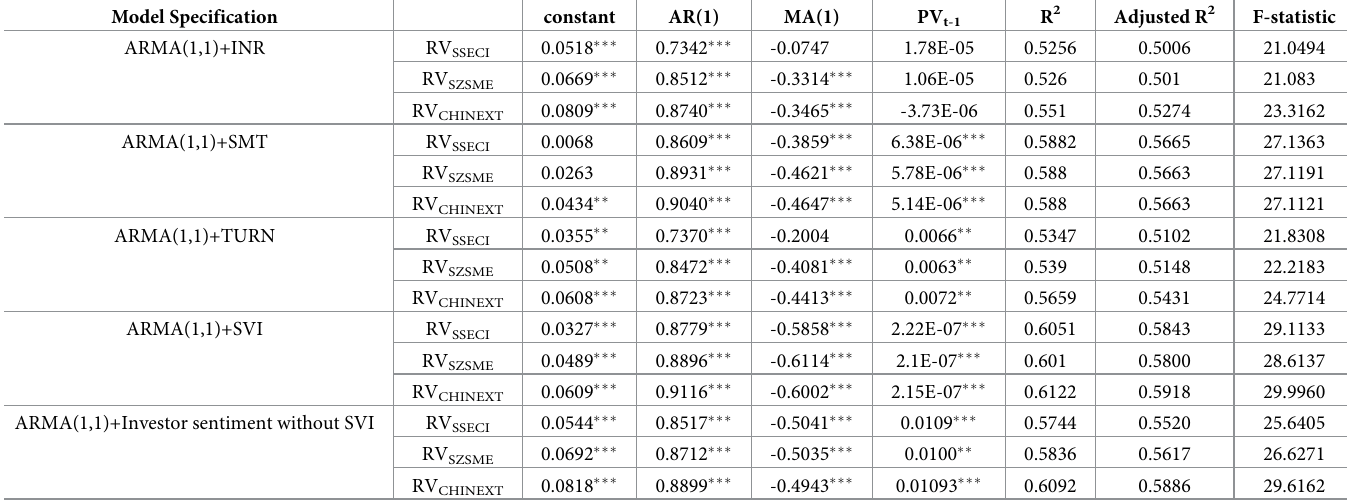
Table 8. Estimated parameters in ARMA(1,1) with different exogenous variables.